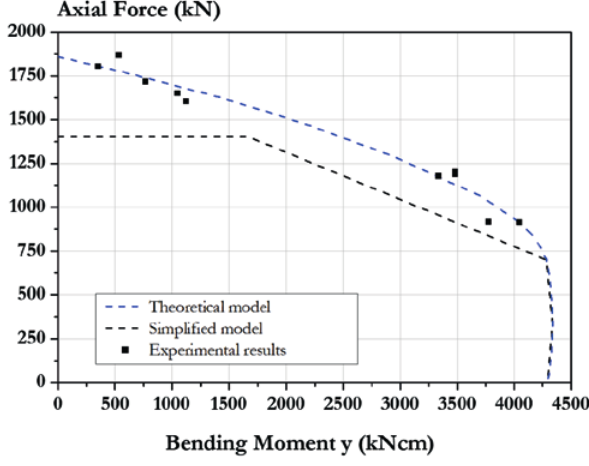
Experimental results and design curves following NBR